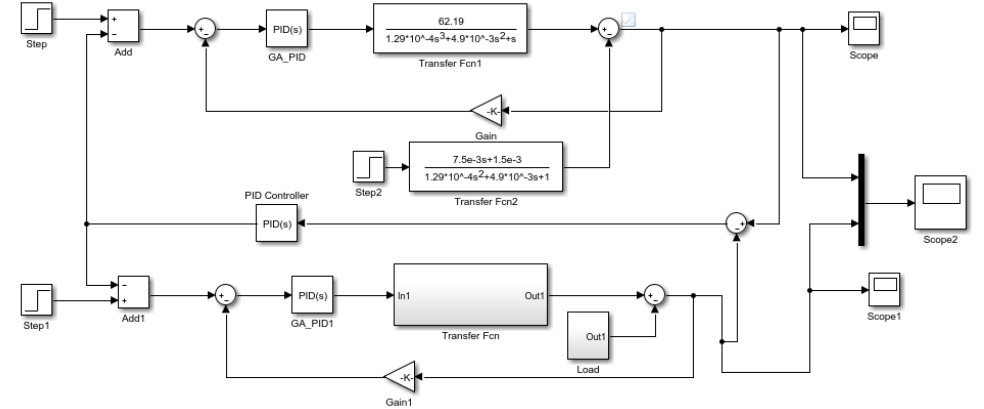
Figure 13. Genetic algorithm self-tuning PID simulation model.